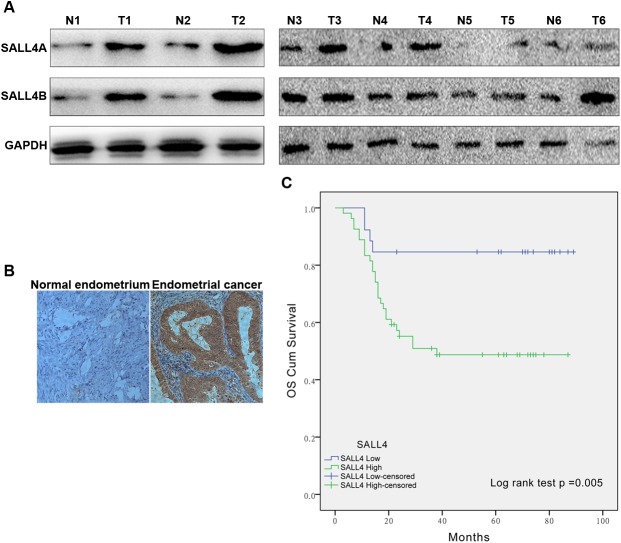
SALL4 expression is upregulated in endometrial cancer and associated with poor prognosis.(A) The expression of SALL4 in endometrial cancer tissues and nontumorous tissues was assessed through western blotting. (B) The images showed immunohistochemical staining of SALL4 in normal endometrium and endometrial cancer tissues (00D7200). (C) Kaplan-Meier analysis indicated that the expression of SALL4 was associated with poor survival of patients.